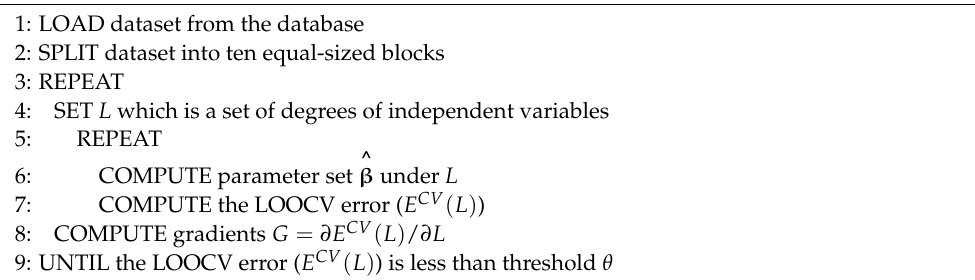
Algorithm 1. Pseudocode for the polynomial regression algorithm with gradient